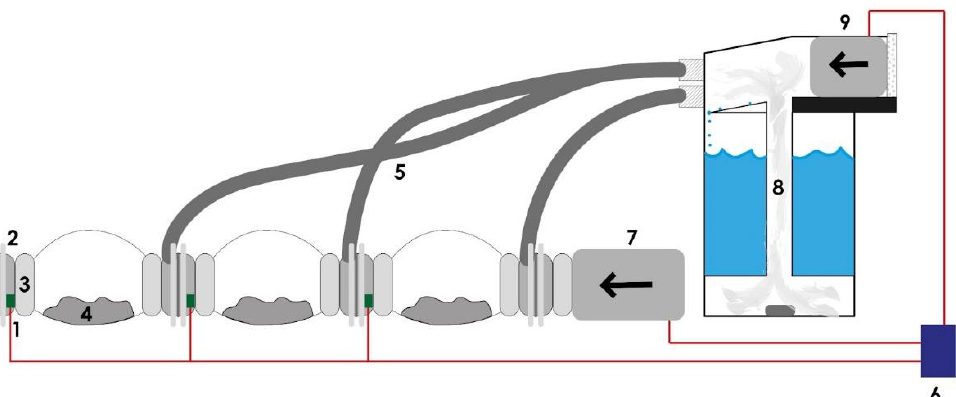
Figure 4. The simplified electrical and mechanical system of the MCB and the humidifier: (1) humidity/temperature sensor, (2) CC, (3) air filter, (4) solid substrate, (5) hose pipe, (6) Arduino, (7) 100 W air blower, (8) vapor chamber, (9) 50 W air blower.